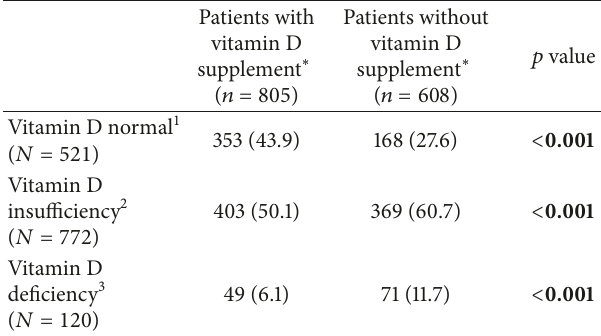
Table 5: Multivariate analysis between vitamin D levels and charac- teristics of RA patients.